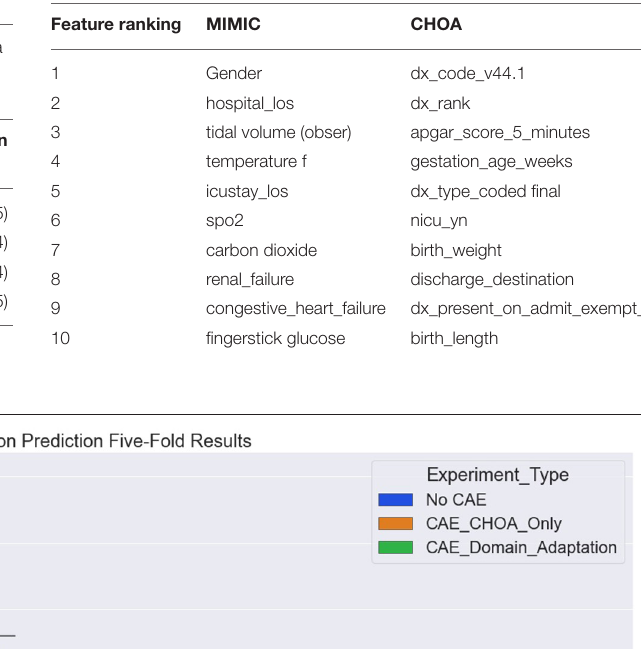
TABLE 7 | Top 10 features in ICU readmission prediction using gradient boosting on Multi-parameter Intelligent Monitoring in Intensive Care (MIMIC) and Children’s Healthcare of Atlanta (CHOA) data.